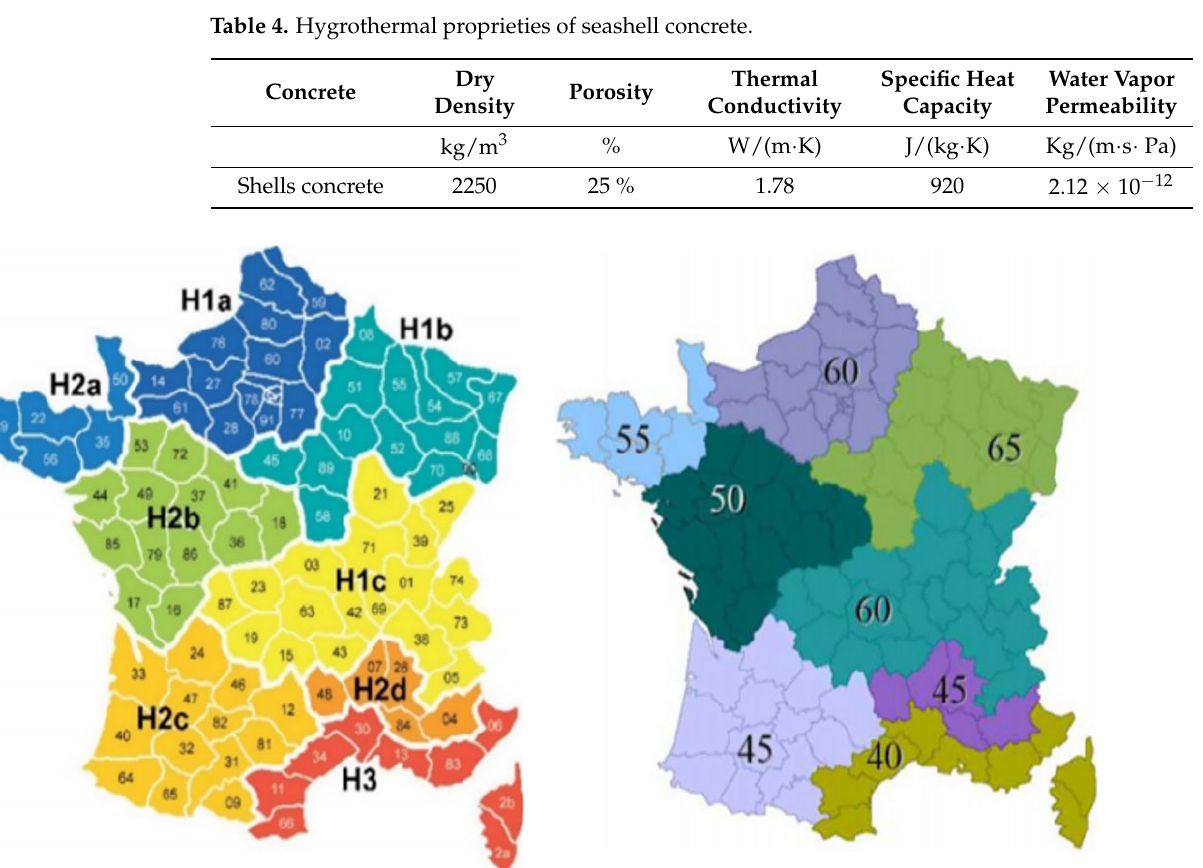
Table 4. Hygrothermal proprieties of seashell concrete.